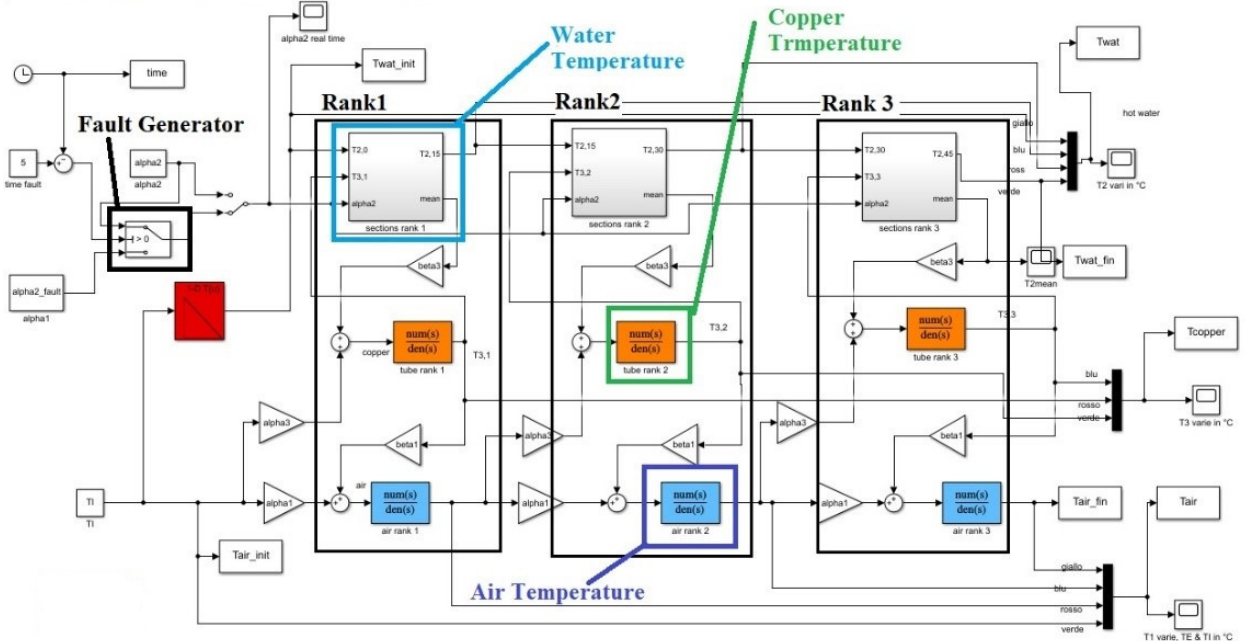
Figure 5. Sketch of the complete Simulink model. Different colors represent respectively water (grey), copper (orange) and air (cyan).